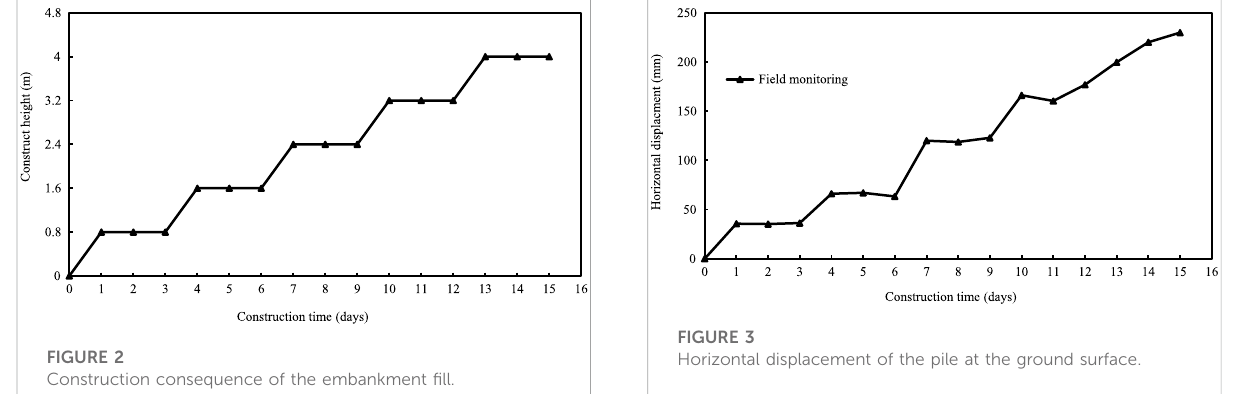
FIGURE 3 Horizontal displacement of the pile at the ground